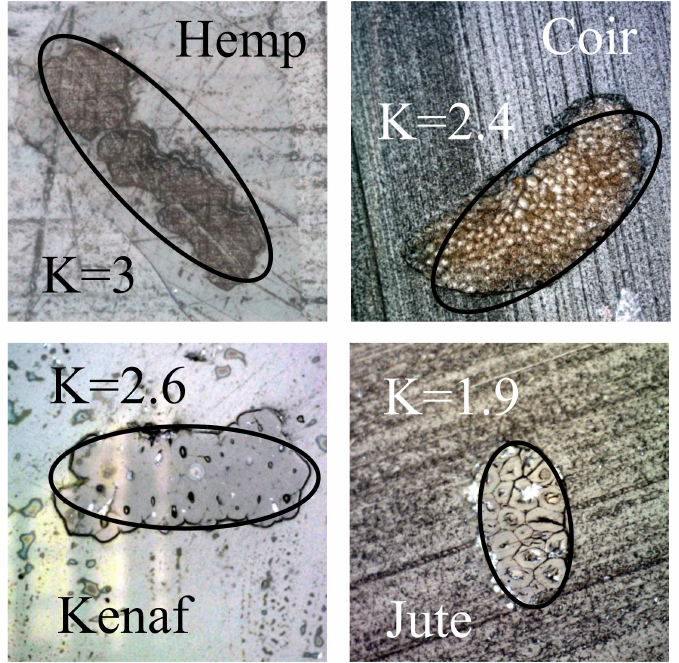
Figure 11. Optical micrographs of various natural fibre cross section